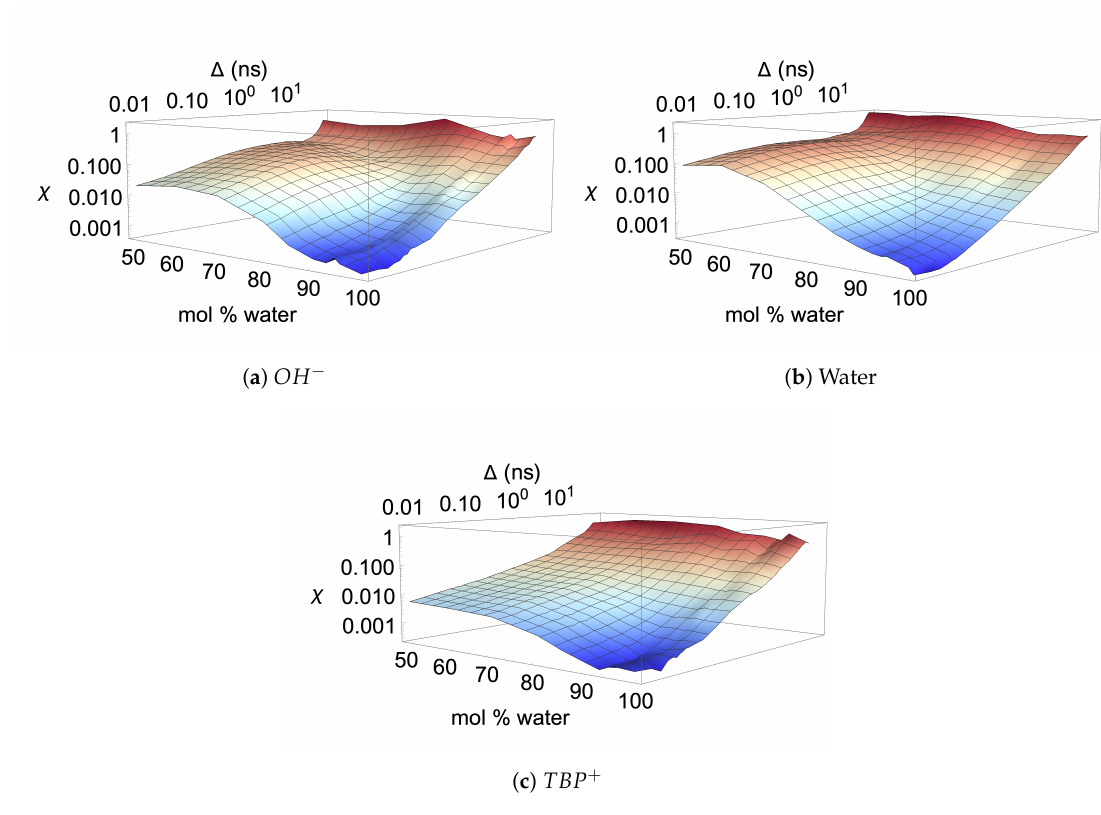
Figure 18. Ergodicity breaking parameter ( χ ) in TBPH–water at p = 1atm and T = 300K as a function of water concentration and lag time for [34]: ( a ) OH − ; ( b ) water; ( c ) TBP + .